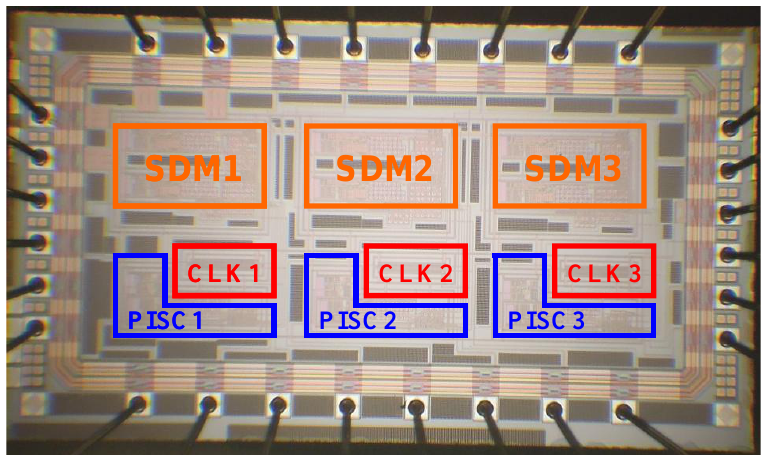
Figure 22. SEM of the proposed sensing